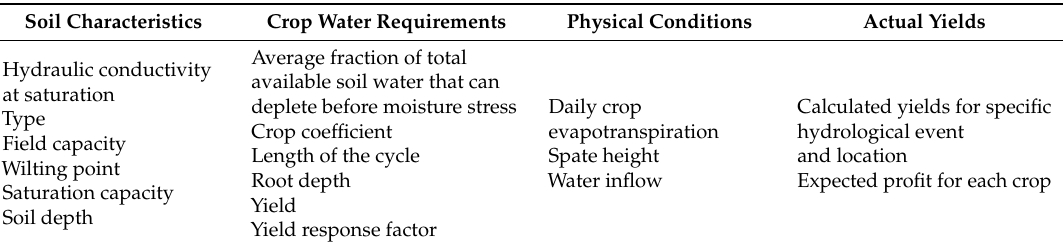
Table 1. Input data for soil moisture